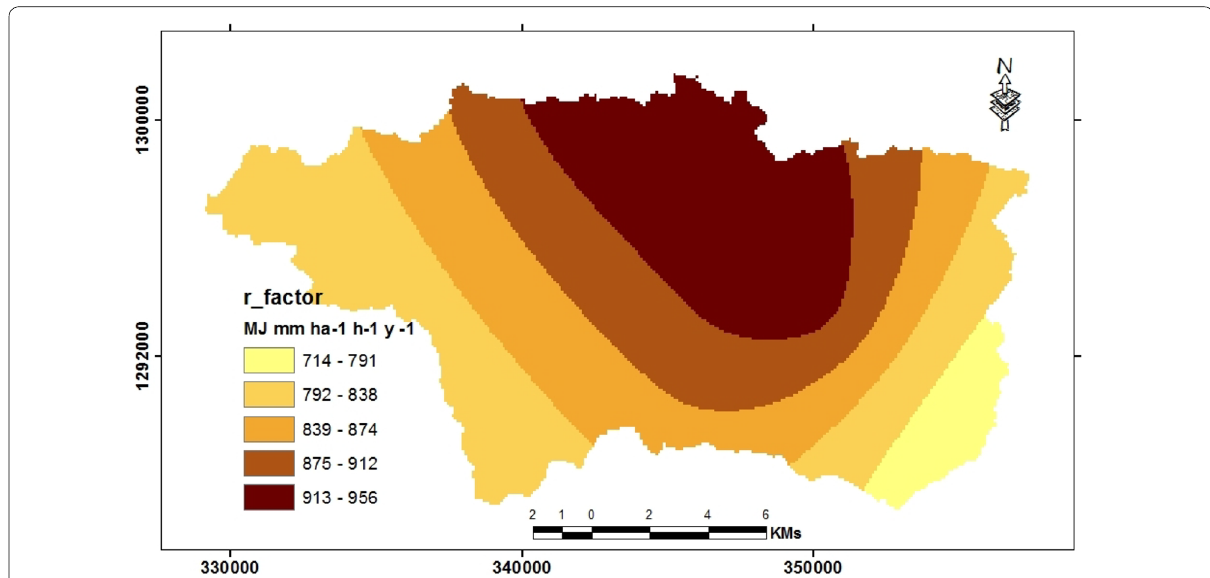
Fig. 5 Isoerodent map of Gelda catchment, Northwestern highlands of Ethiopia